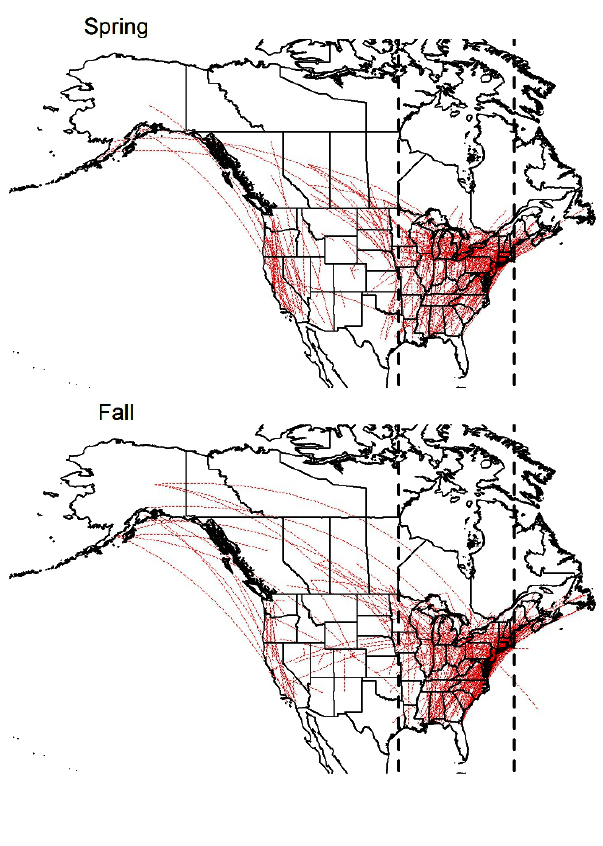
Fig. 3 . Great circle migration routes of passerines during spring (n = 711) and fall (n = 550) migration from birds banded and subsequently recovered between 1914 and 2004 (restricted to records with termini north of 30 degrees latitude). Dashed lines indicate divisions used in subset data for circular ANOVA analyses (see Methods, Tables 3 and